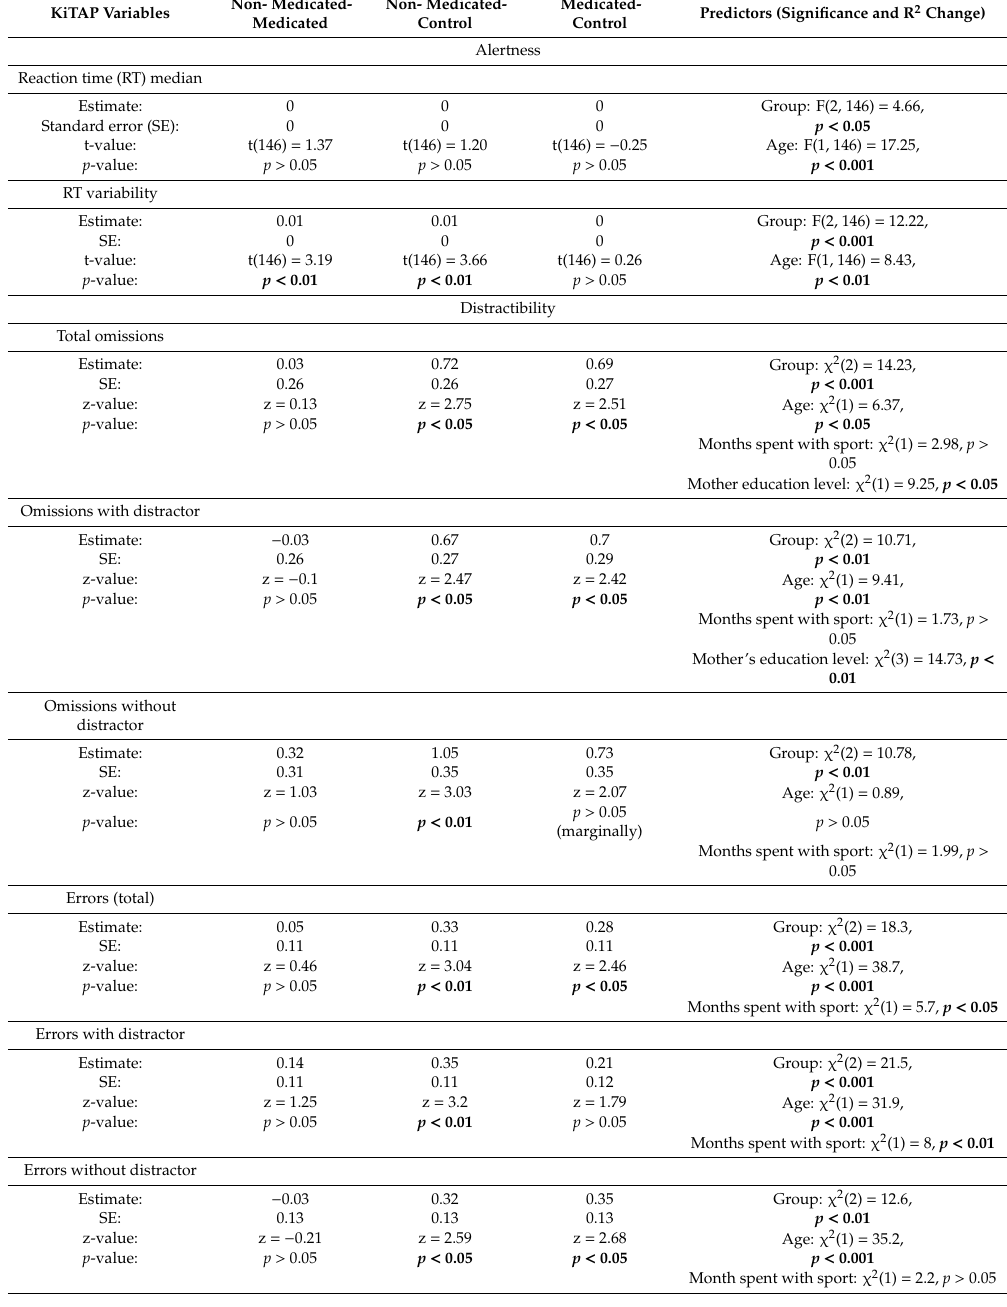
Table 2. Post hoc tests and